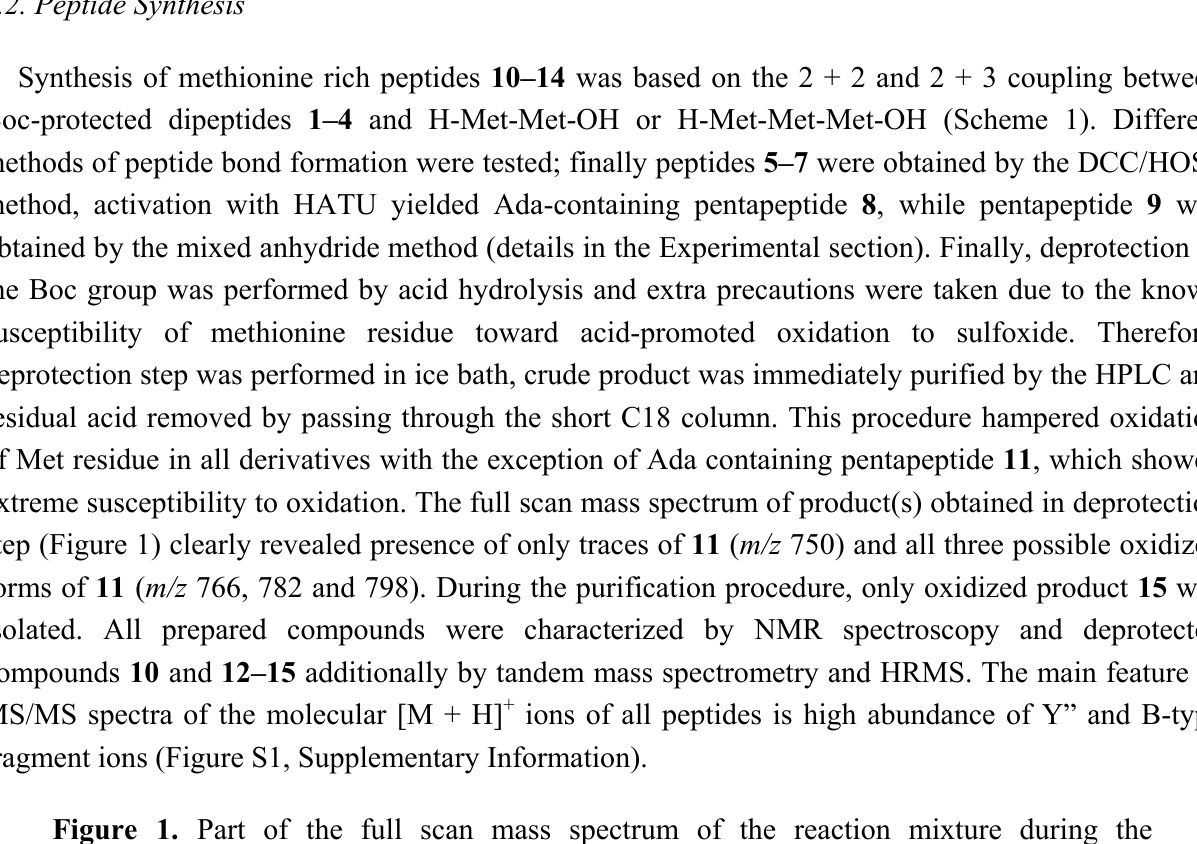
Figure 1. Part of the full scan mass spectrum of the reaction mixture during the deprotection of 8 showing presence of oxidized forms of